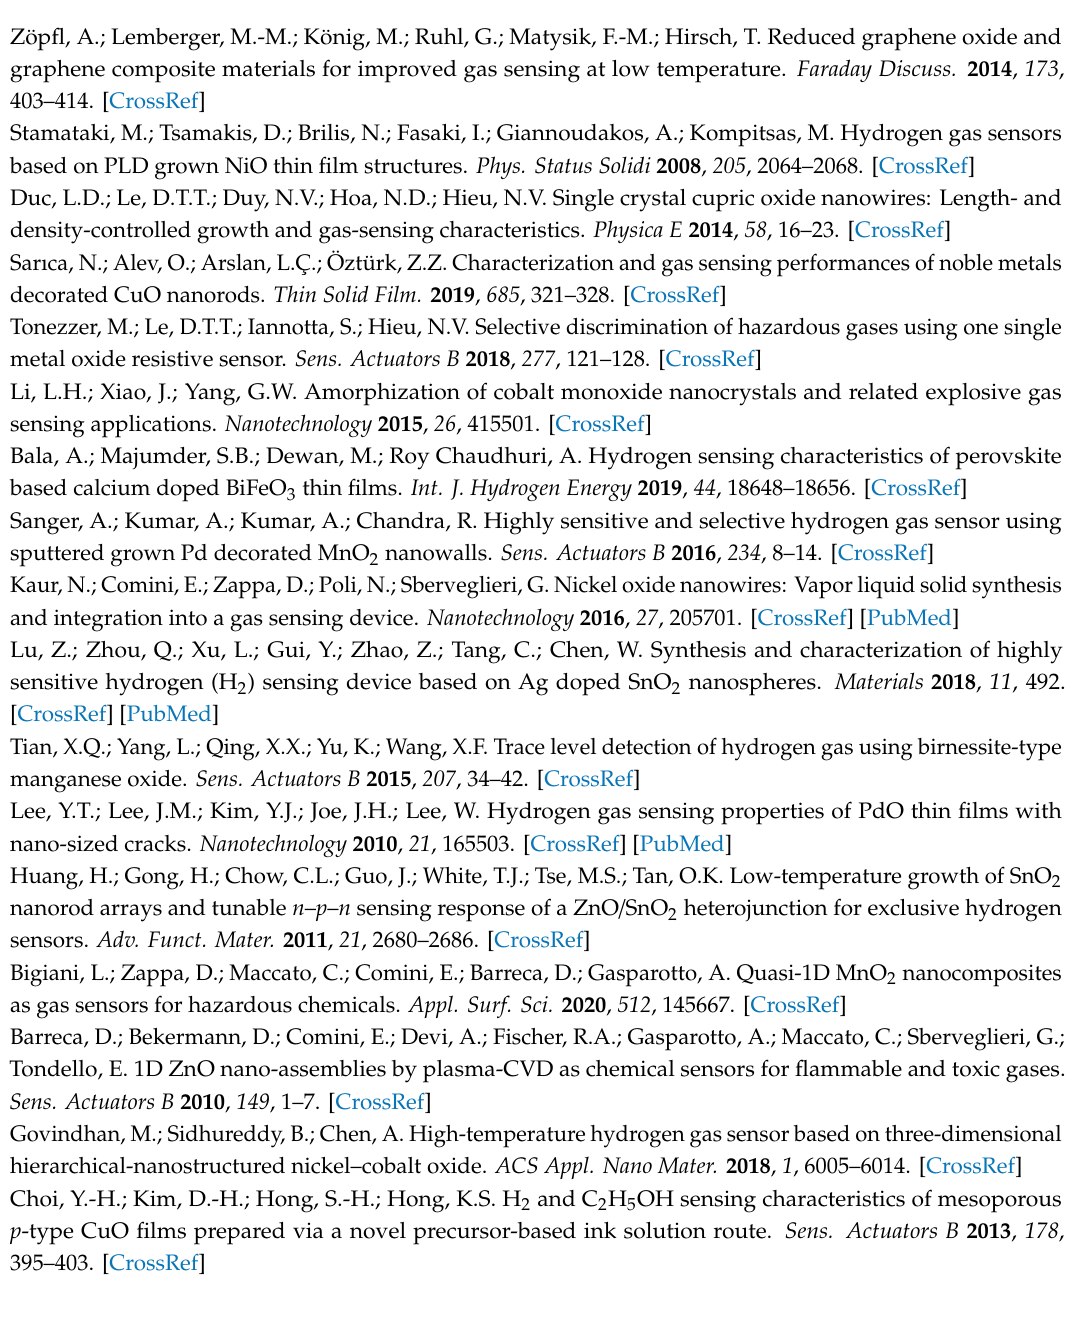
Figure S1: Surface silver Auger signal for the Mn 3 O 4 -Ag specimen, Figure S2: Deconvolution of surface O1s XP spectra for Mn 3 O 4 -based samples, Figure S3: Gas responses as a function of H 2 concentration for bare and functionalized Mn 3 O 4 sensors, Figure S4: Gas responses to fixed CO 2 , CH 4 , and H 2 concentrations for Mn 3 O 4 -Ag and Mn 3 O 4 -SnO 2 sensors, response time data, calculation of the HAL